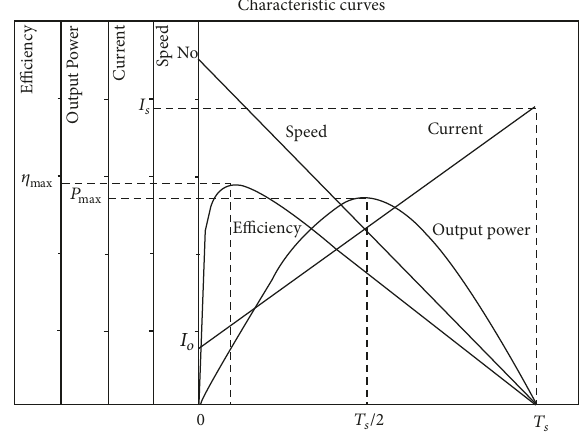
Figure 14: Typical torque versus speed, current, and power curves for a PMDC motor.